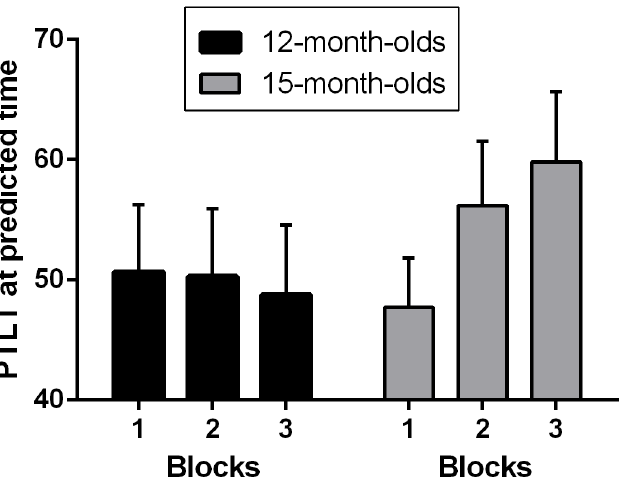
Fig 4. Percentage of total looking time (PTLT) at correct side during the expected time (500msprior to target) for each age group in each of the three blocks. Bars indicate standarderror of the mean.